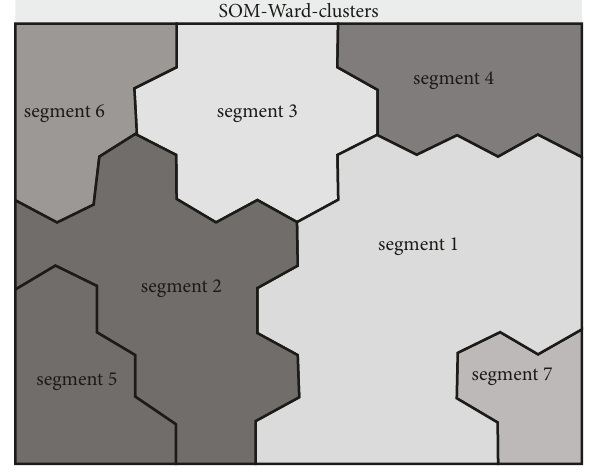
Figure 6: Demarcation of clusters.